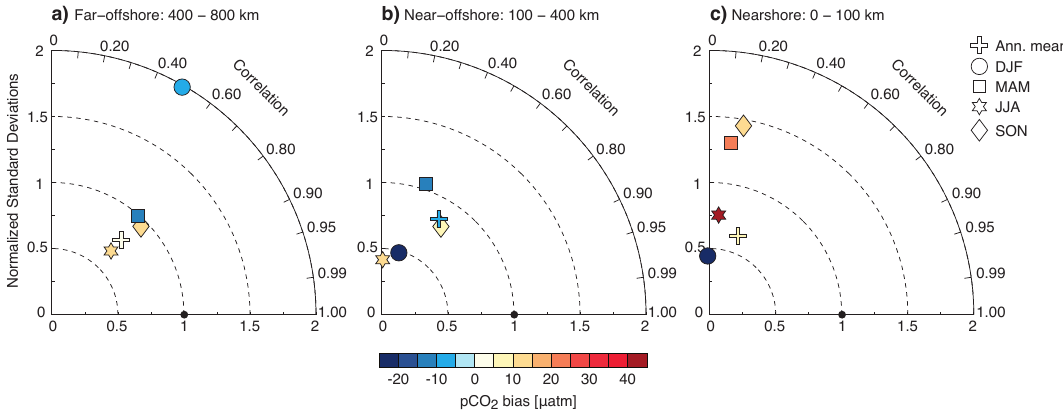
Fig. 3. Taylor diagrams (Taylor, 2001) of modeled vs. observed p CO 2 for the far-offshore (a) , near-offshore (b) and nearshore (c) sub- domains. Observations are from the Surface Ocean CO 2 Atlas (SOCAT Version 2; Pfeil et al., 2013), the global surface p CO 2 database (Takahashi et al., 2013) and the MBARI/CalCOFI Line 67 (Collins et al., 2003). The distance to the origin point (dashed lines) indicates the modeled field’s normalized standard deviation (i.e. a value of 1 would mean a perfect agreement with the observed spatial variability). The angle between each model point and the vertical axis represents the spatial correlation coefficient (“Pearson correlation”) for the model vs. the observations. The distance from the observation reference point (black dot) to the model point is that model field’s central pattern root-mean square. The color code indicates the bias of the modeled vs. the observed p CO 2 : positive values mean the model overestimates p CO 2 and vice